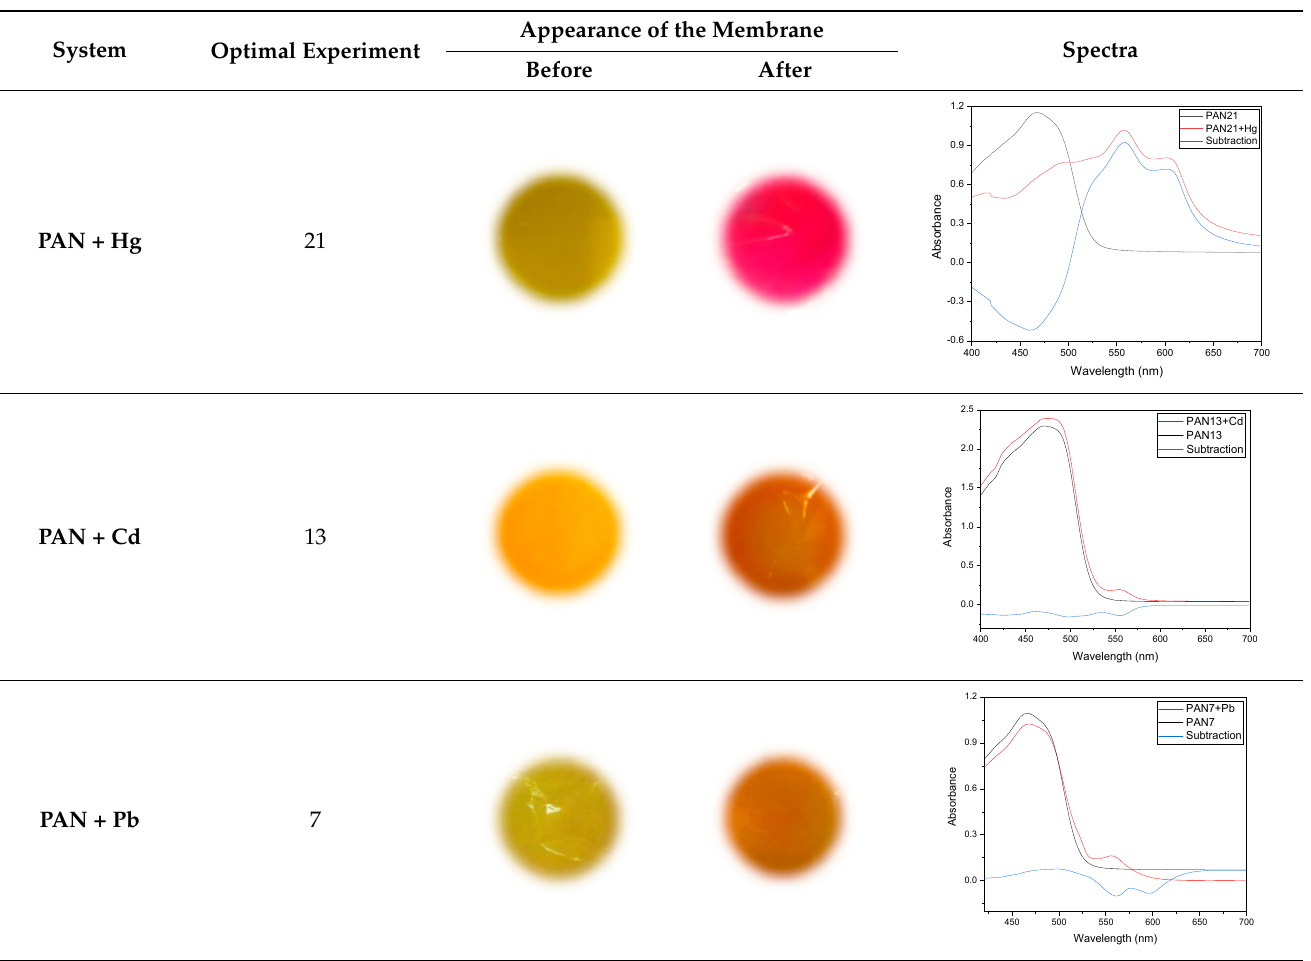
PAN + Hg PAN + Hg 21